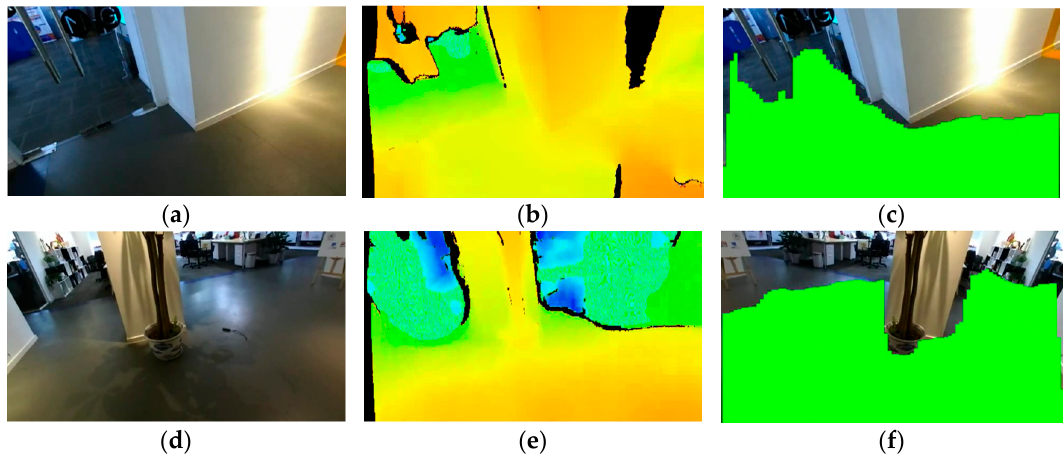
Figure 13. Detection limitations. ( a – c ) Detection with defective depth information; ( d – f ) Small obstacles would be detected as traversable area.